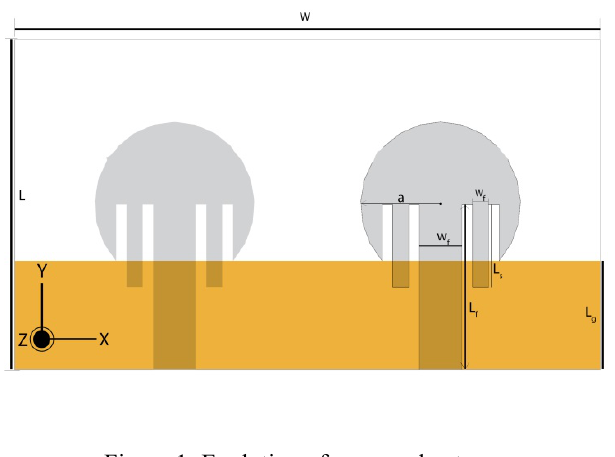
Figure 1: Evolution of proposed antenna